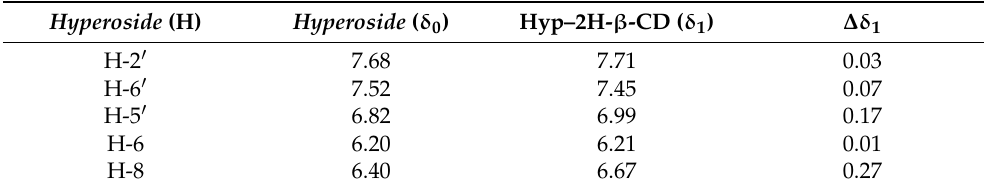
Table 1. 1 H NMR chemical shifts of Hyp before and after interaction with 2H- β